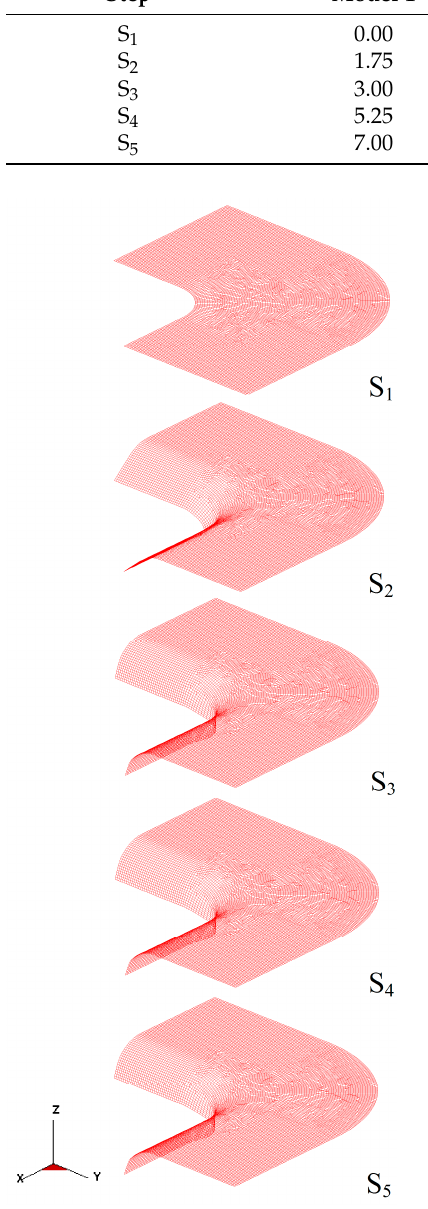
Figure 2. Tensile deformation history of the flange. Table 5. Relevant stroke parameters of the flange (unit: mm).